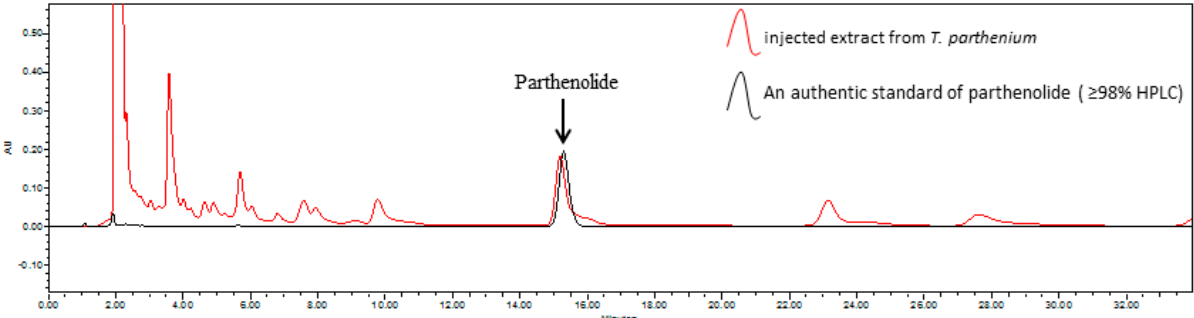
Fig. 7. The HPLC analysis of extract from T. parthenium and 110 ppm of standard partenolide from Sigma-Aldrich company (USA). Min- utes: Run time, AU: Absobtion